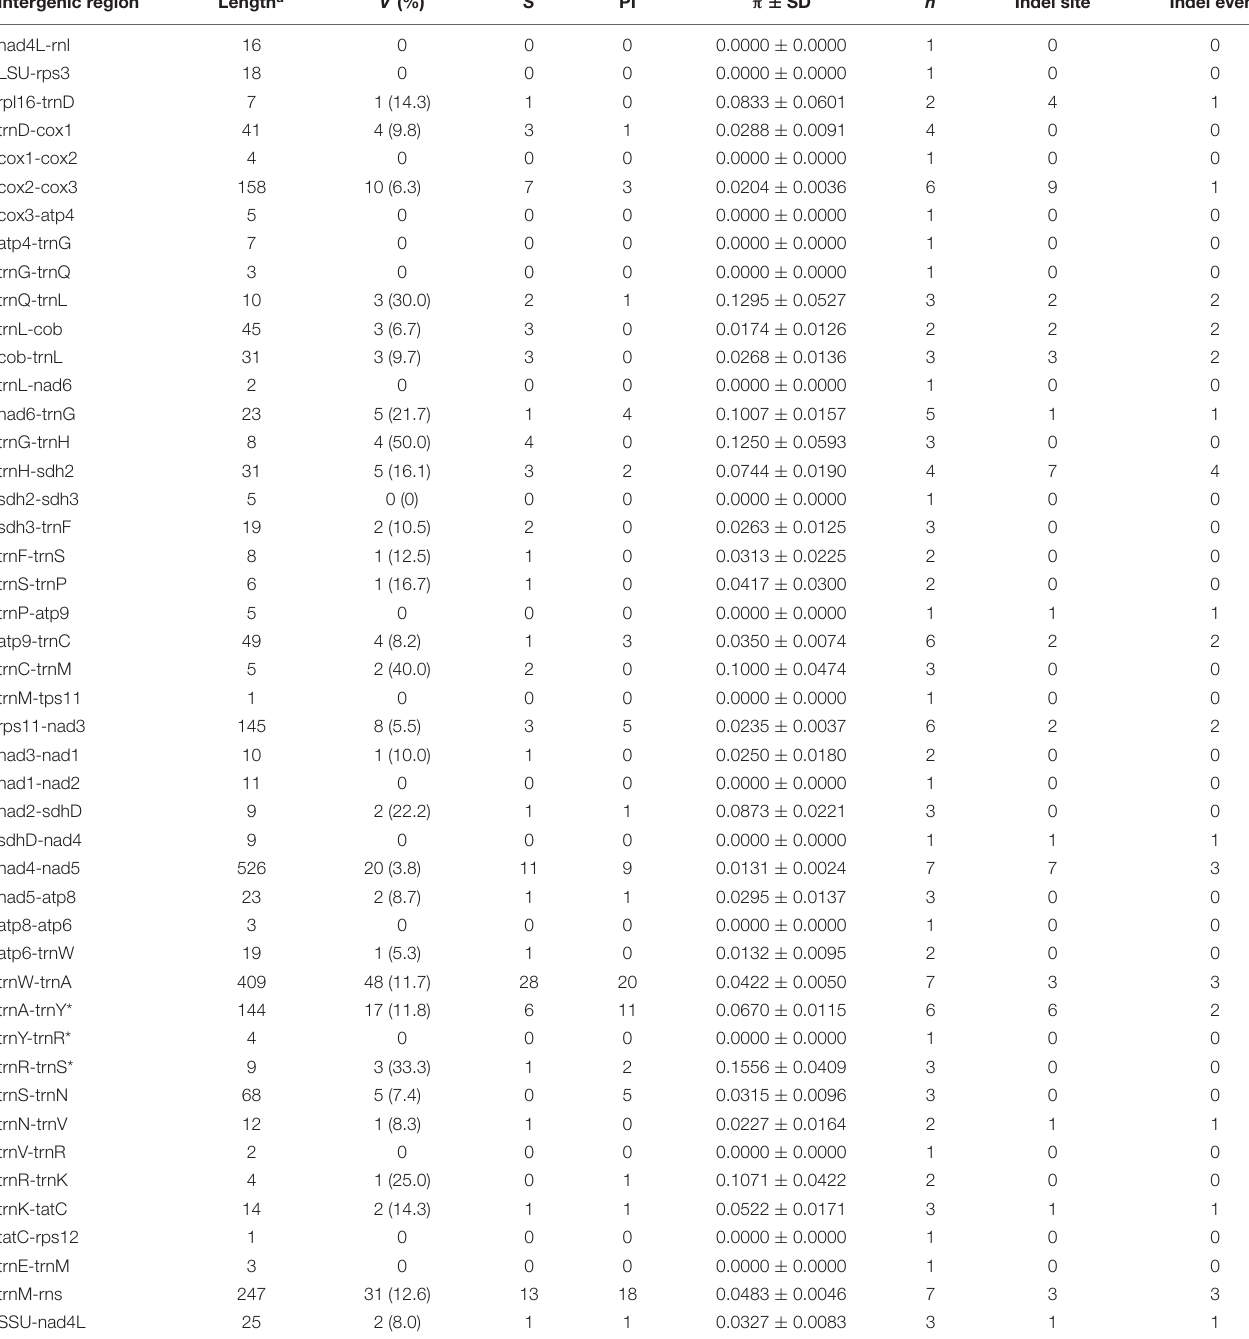
TABLE 3 | A comparison of intergenic spacers in Gelidiella fanii . Intergenic